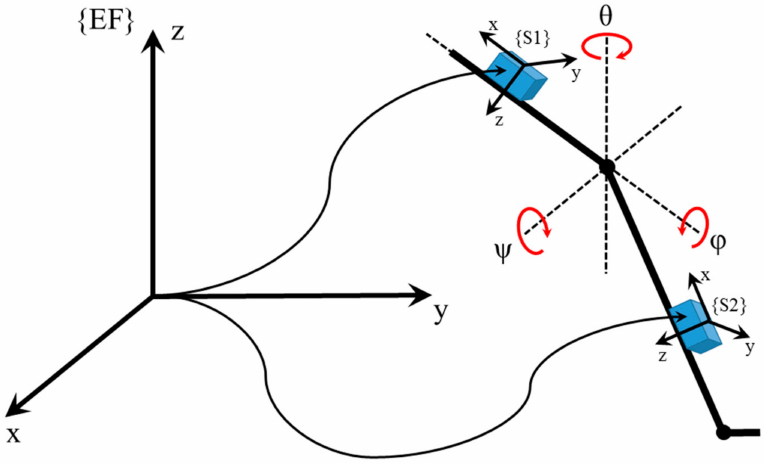
Figure 1. The coordinate system of the sensory system used in the